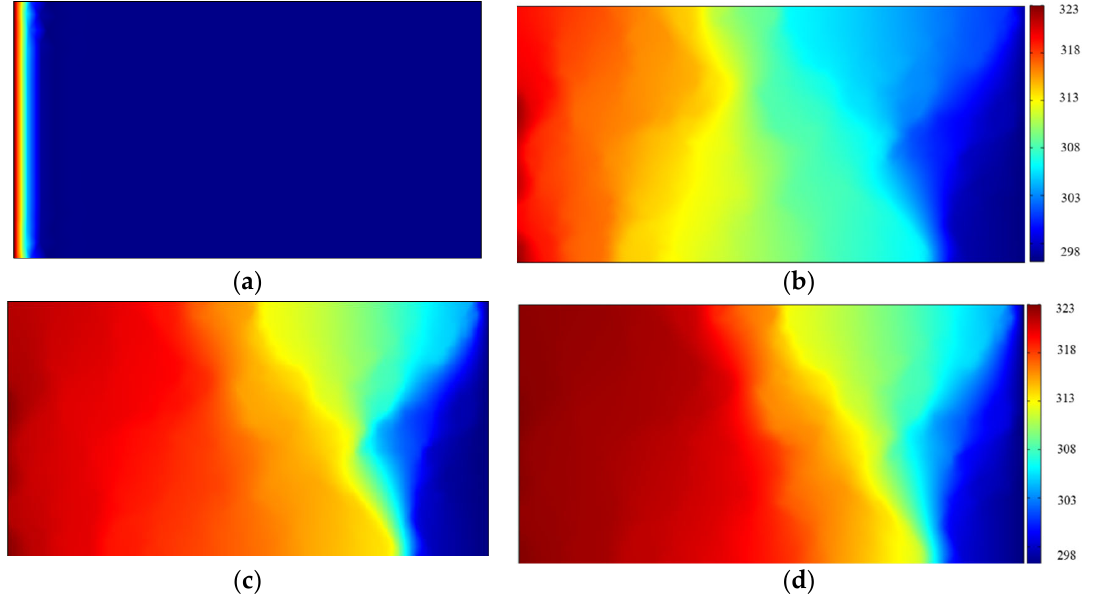
Figure 7. The temperature distribution at different times. ( a ) 0.2 min; ( b ) 2 min; ( c ) 8 min; ( d ) 10 min.